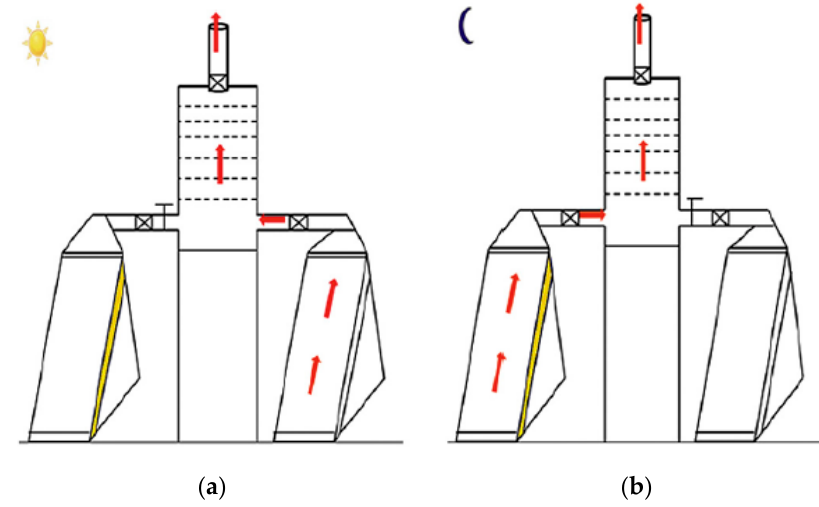
Figure 3. Operation principle of the ISD with phase change material (PCM): ( a ) daytime, ( b ) nighttime (figure taken from El Khadraoui et al. [26]).